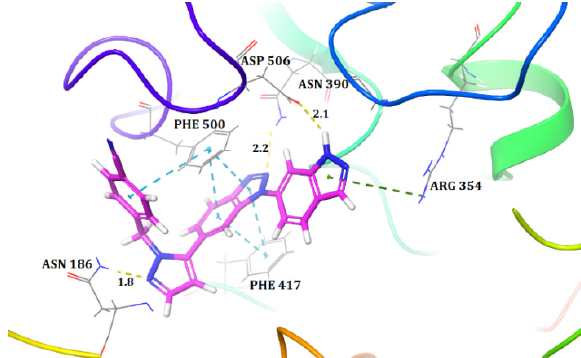
Figure 1. Docked pose of the most active compound, 48 , inside the active site of CD73 (Hydrogen bonds are represented as yellow dotted lines, pi–pi interactions are represented as cyan dotted lines, and pi–cation interactions are represented as green dotted lines).